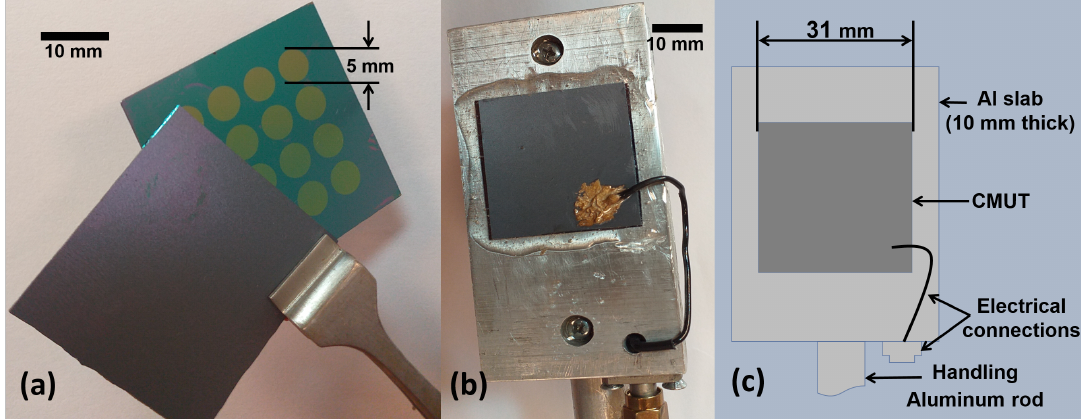
Figure 3. Device during fabrication stages: ( a ) before bonding, ( b ) final device, and ( c ) schematic of final